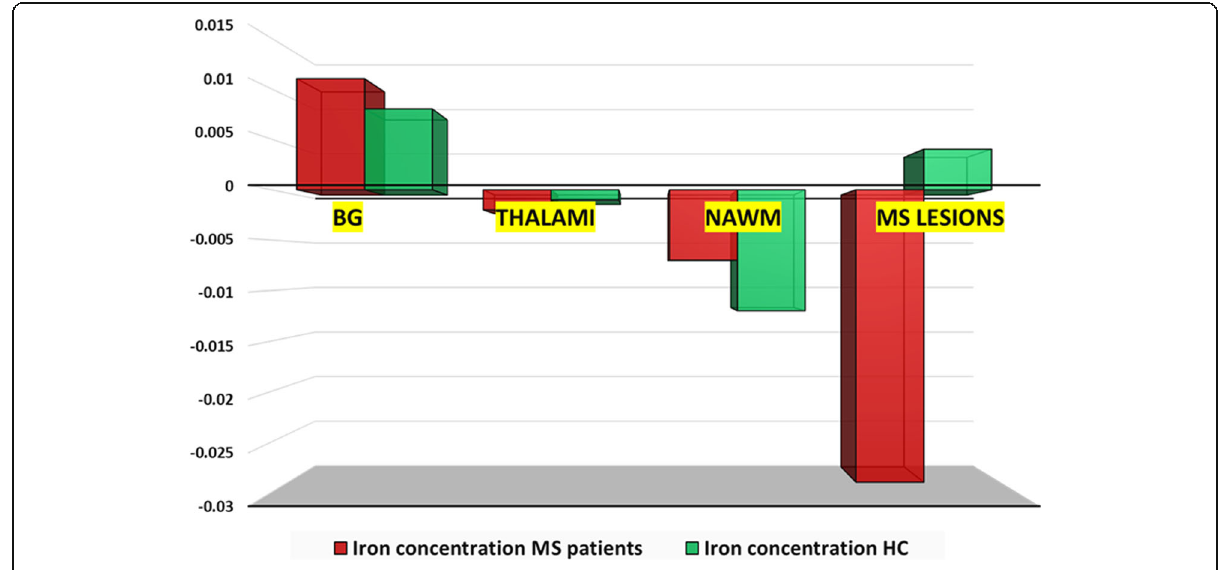
Fig. 5 Regional iron concentrations in multiple sclerosis patients versus healthy controls